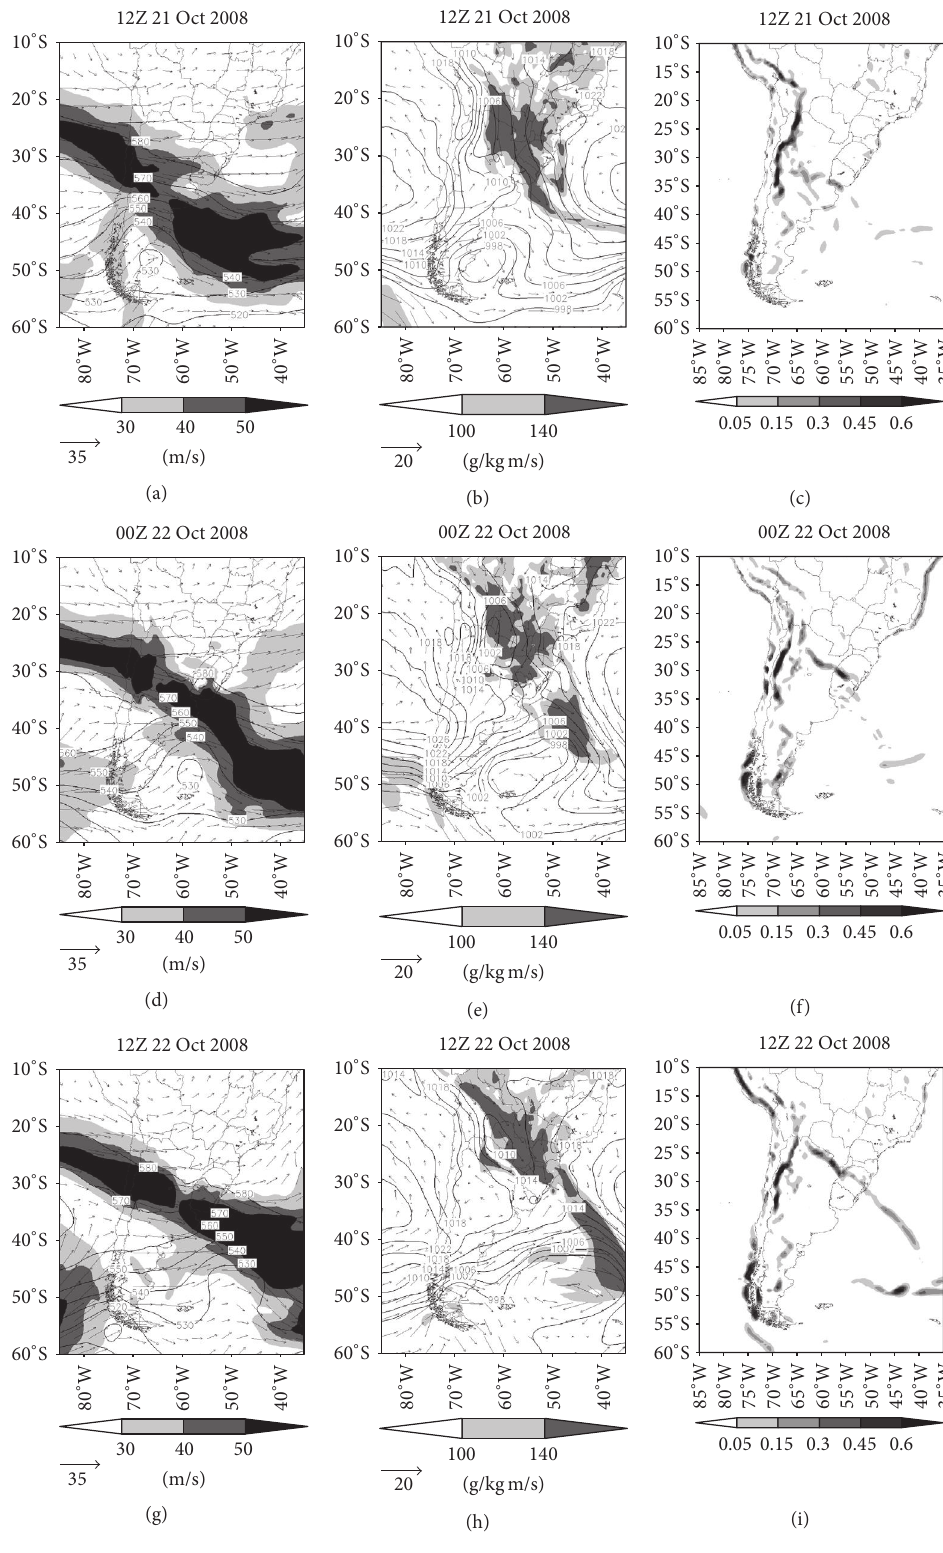
Figure 4: Atmospheric fields from NCEP CSF Reanalysis valid at 12Z 21 October 2008 ((a)–(c)), 00Z 22 October 2008 ((d)–(f)), and 12Z 22 October 2008 ((g)–(i)). (a), (d), and (g): 500 hPa geopotential heights (black contours, in dam), 200hPa winds (vectors, in ms −1 ; reference vector indicated in the bottom of (a), (d), and (g)), and wind speed (grey shading, in m s −1 ; shading scale provided at the bottom of (a), (d), and (g)). (b), (e), and (h): mean sea level pressure (black contours, in hPa), 850 hPa winds (vectors, in ms −1 ; reference vector indicated at the bottom of (b), (e), and (h)), and moisture flux (grey shading, in g kg −1 ms −1 ; shading scale provided at the bottom of (b), (e), and (h)). (c), (f), and (i): surface frontogenetic function, only where it is equal to or greater than 0.05 × 10 −8 Km −1 s −1 (see shading scale provided at the bottom of (c), (f), and